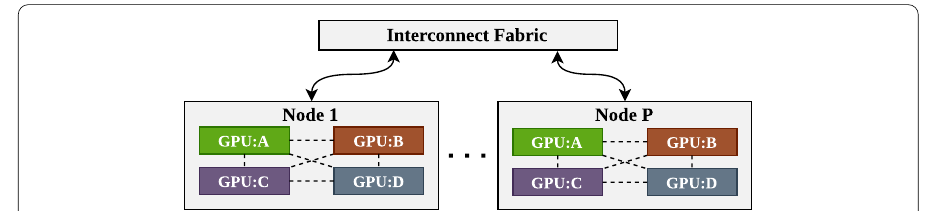
Fig. 1 MPI Groups An overview of a common node-based computer cluster with P nodes and four GPUs per node. GPU colors represent group membership. The dashed lines indicate GPU-to-GPU communication channels